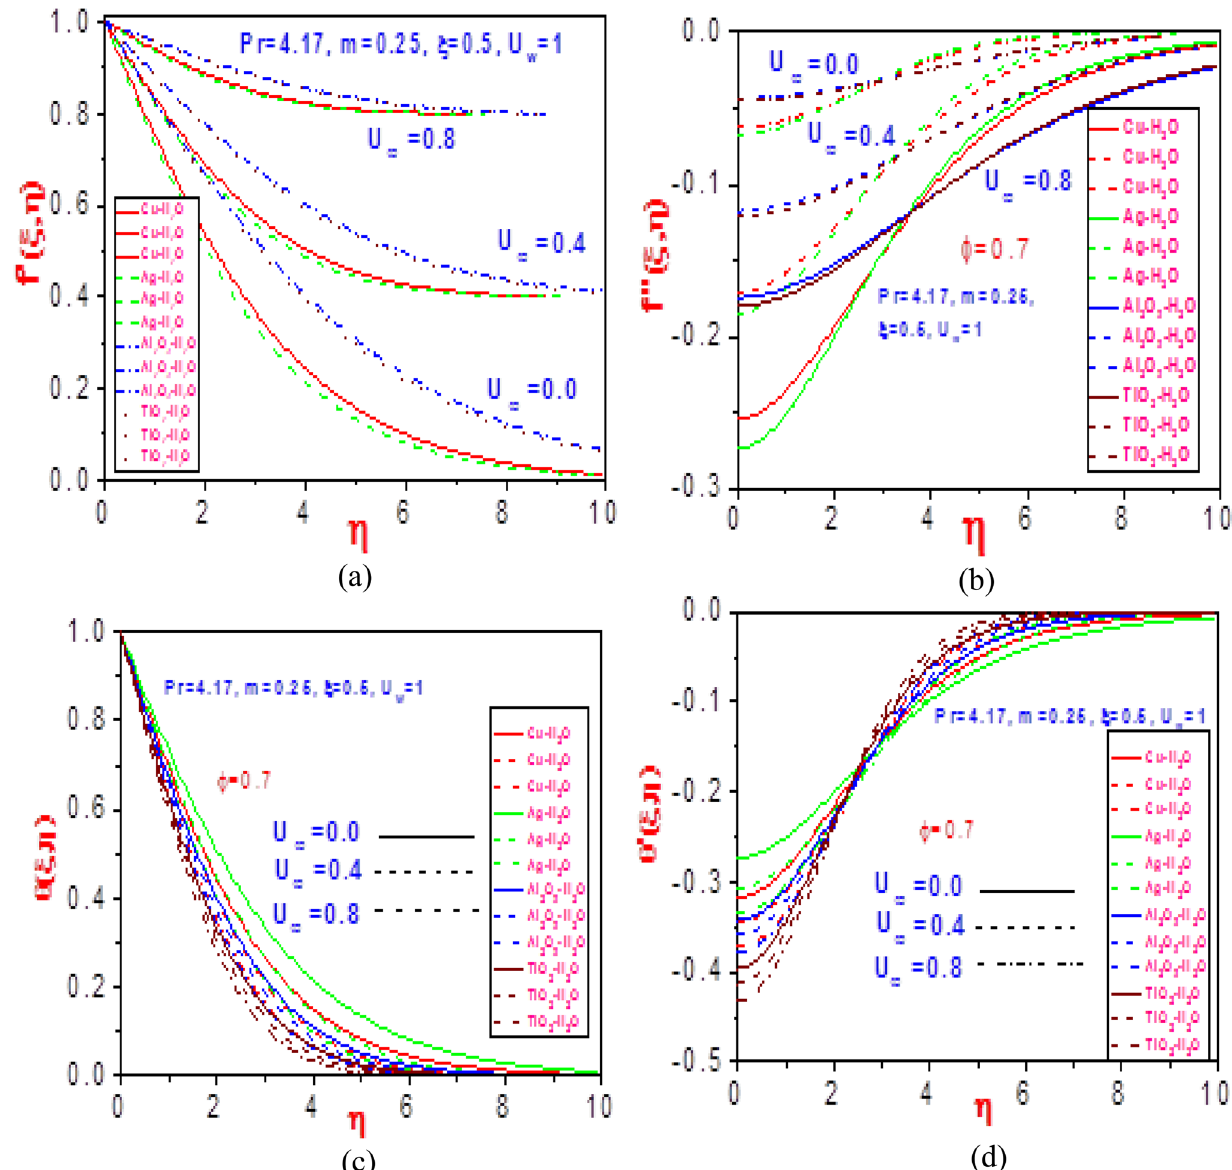
Figure 15. Profiles of ( a ) velocity f ′ (ξ , η) , ( b ) missing velocity slope f ′′ (ξ , η) , ( c ) temperature θ(ξ , η) and (d) missing temperature slope θ ′ (ξ , η) with different values of U ∞ and φ = 0.7 for Cu-H 2 O, Ag-H 2 O, Al 2 O 3 -H 2 O and TiO 2 -H 2